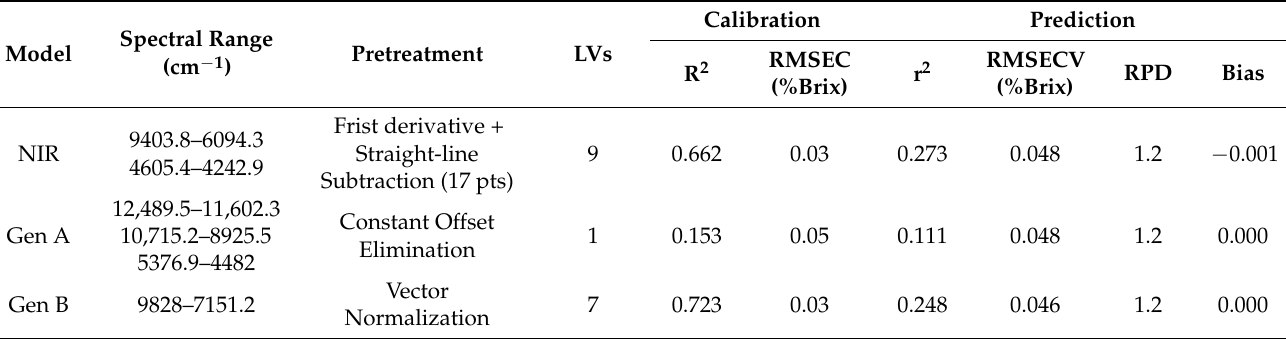
Table 6. PLSR models for mangosteen pur é e TA